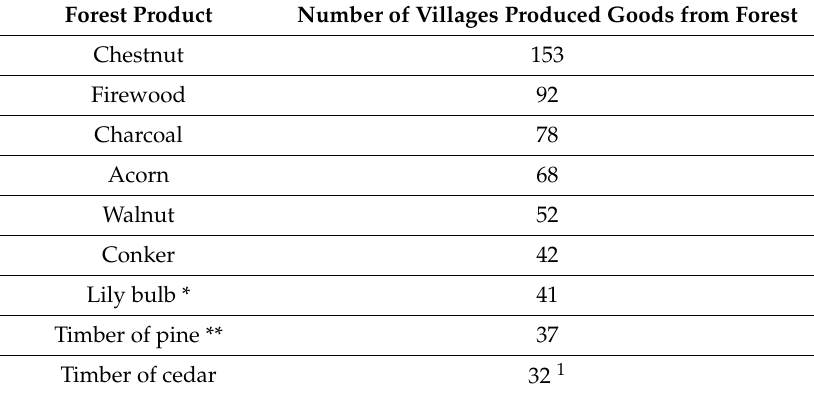
Table 1. Major forest products frequently listed in the